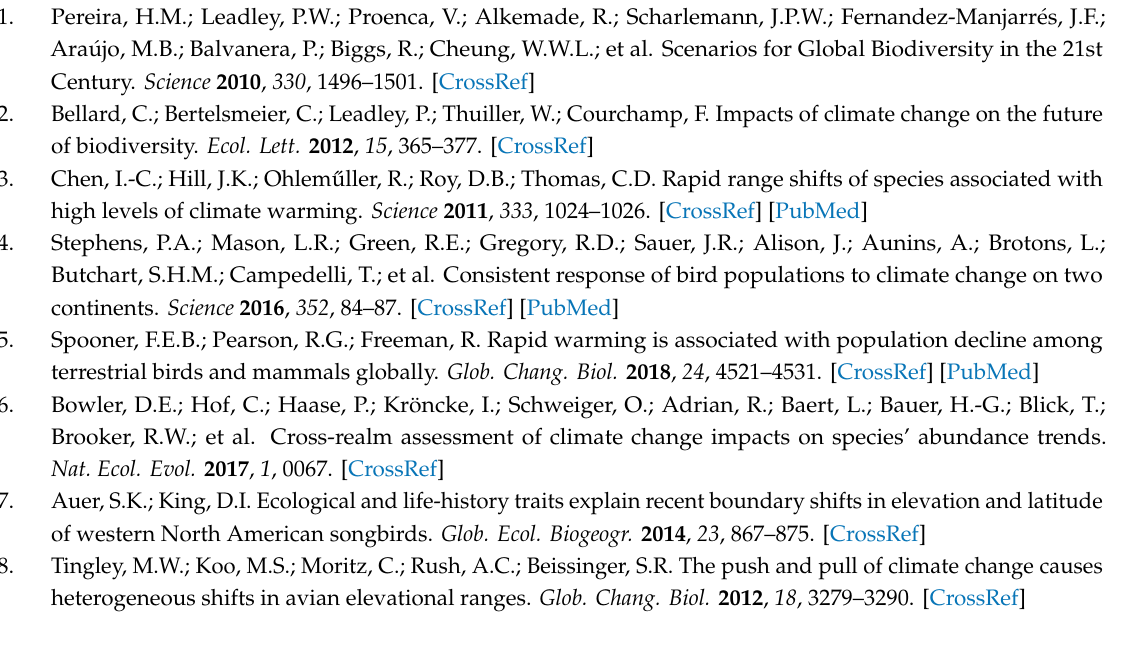
Table S1. Protected areas studied. Figure S1. The agreement between observed and interpolated monthly average air temperatures